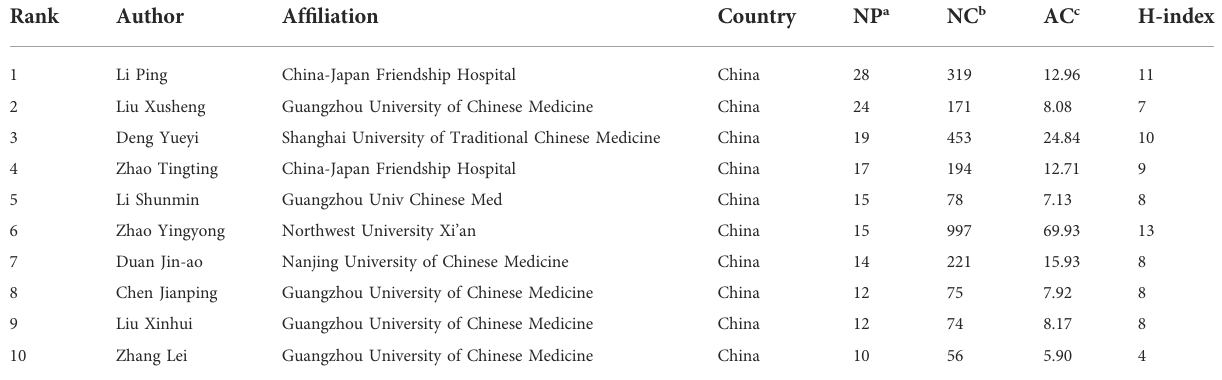
TABLE 3 The top 10 active authors in the fi eld of herbal medicine to control